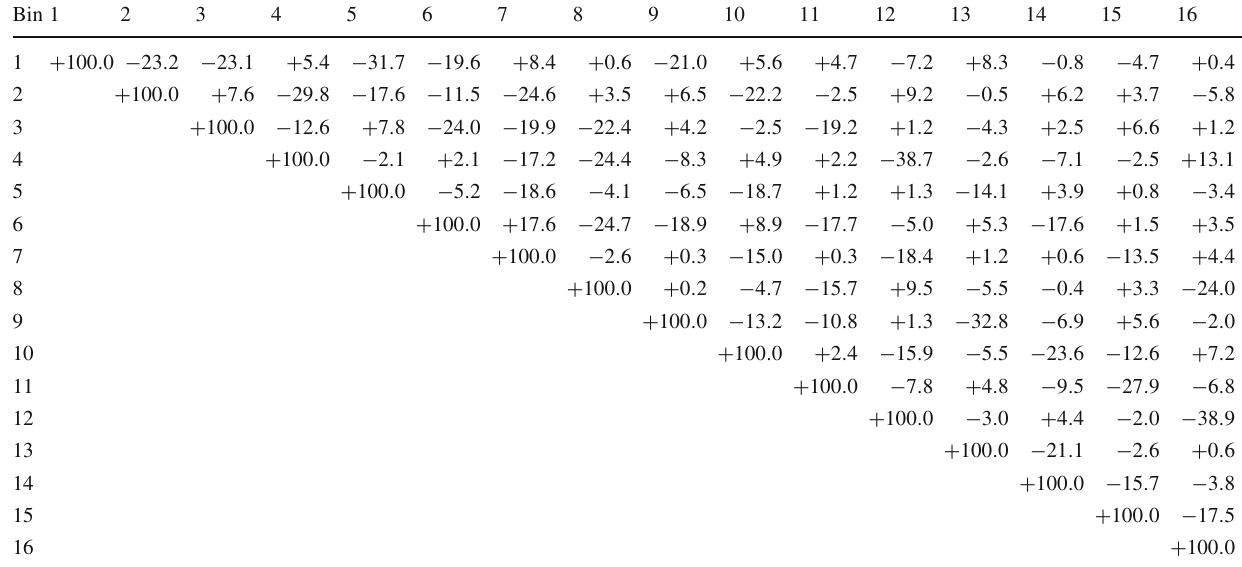
Table 12 The correlation matrix of statistical uncertainties for the normalized tt double-differential cross sections as a function of M ( tt ) and y ( tt ) . The values are expressed as percentages. For bin indices see Table 11 Bin